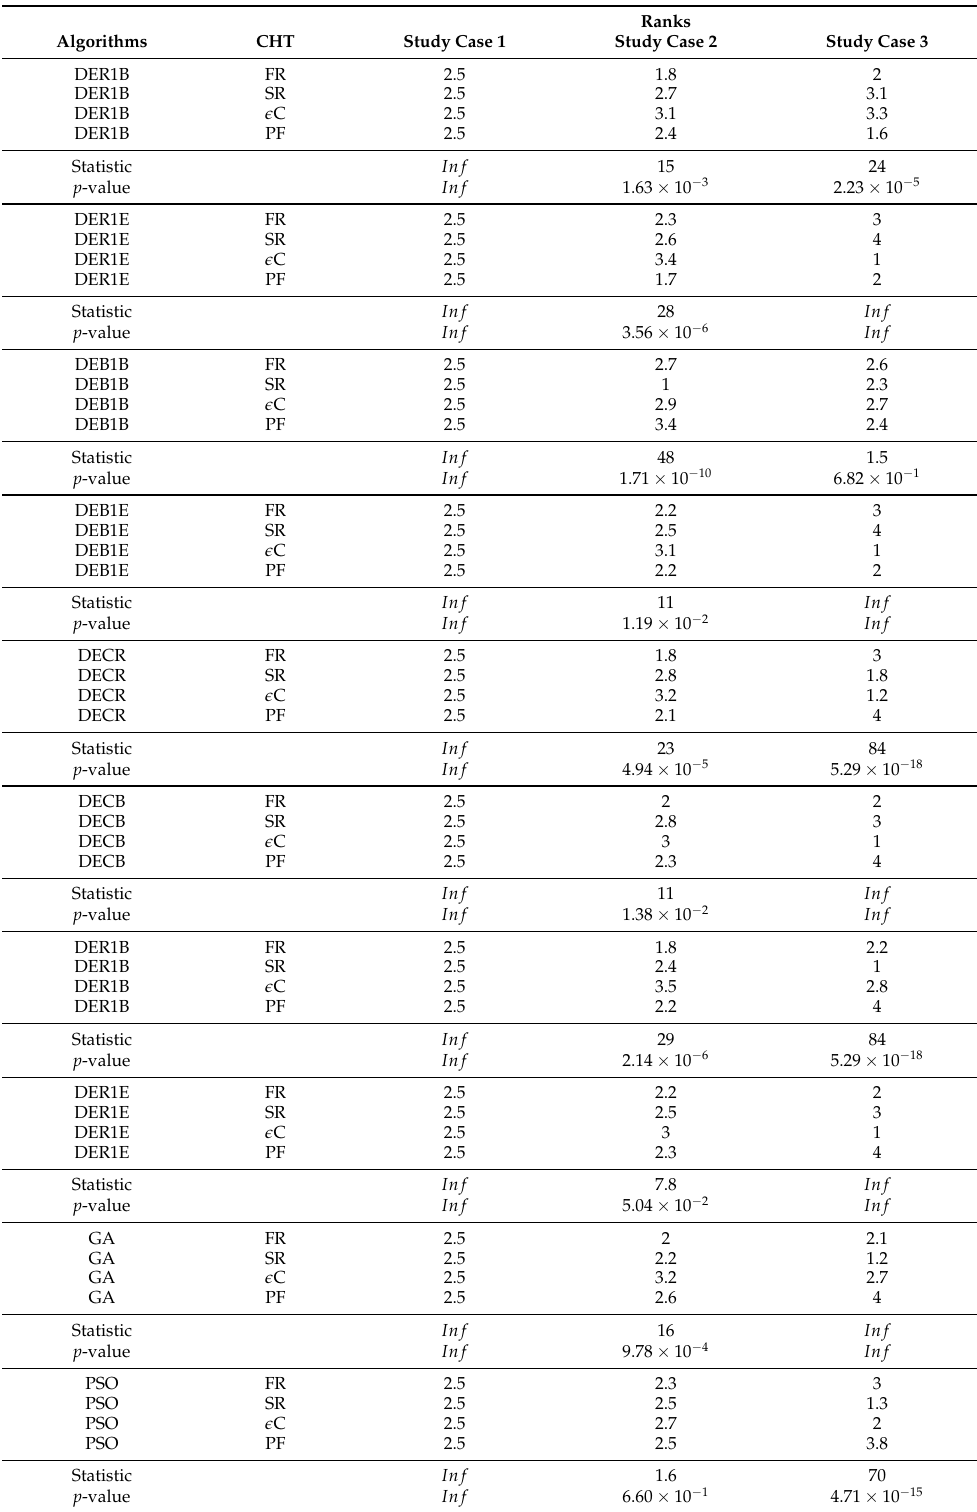
Table A19. Ranks and p -value obtained by the Friedman test for the EVALS metric. A p -value less than 0.05 indicates that at least two groups of values for each algorithm are